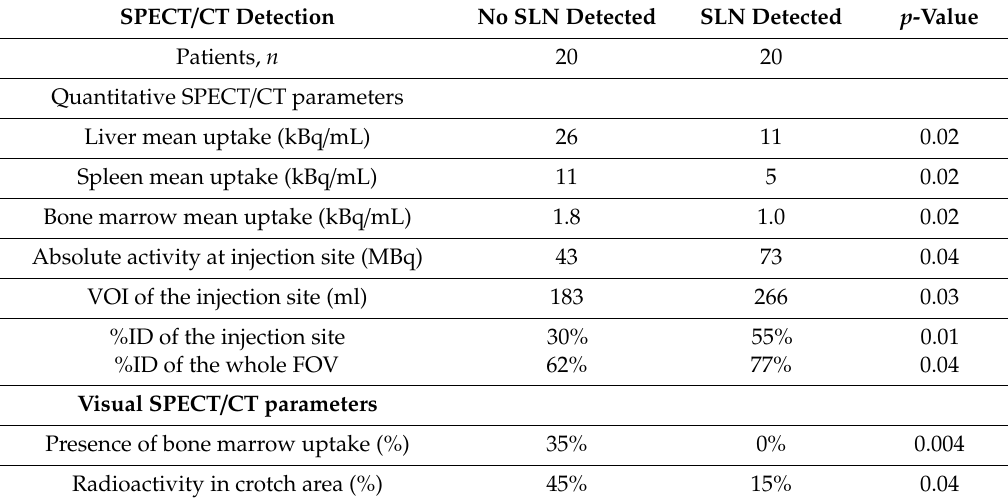
Table 2. Parameters significantly a ff ecting pre-operative SLN detection by SPECT / CT.